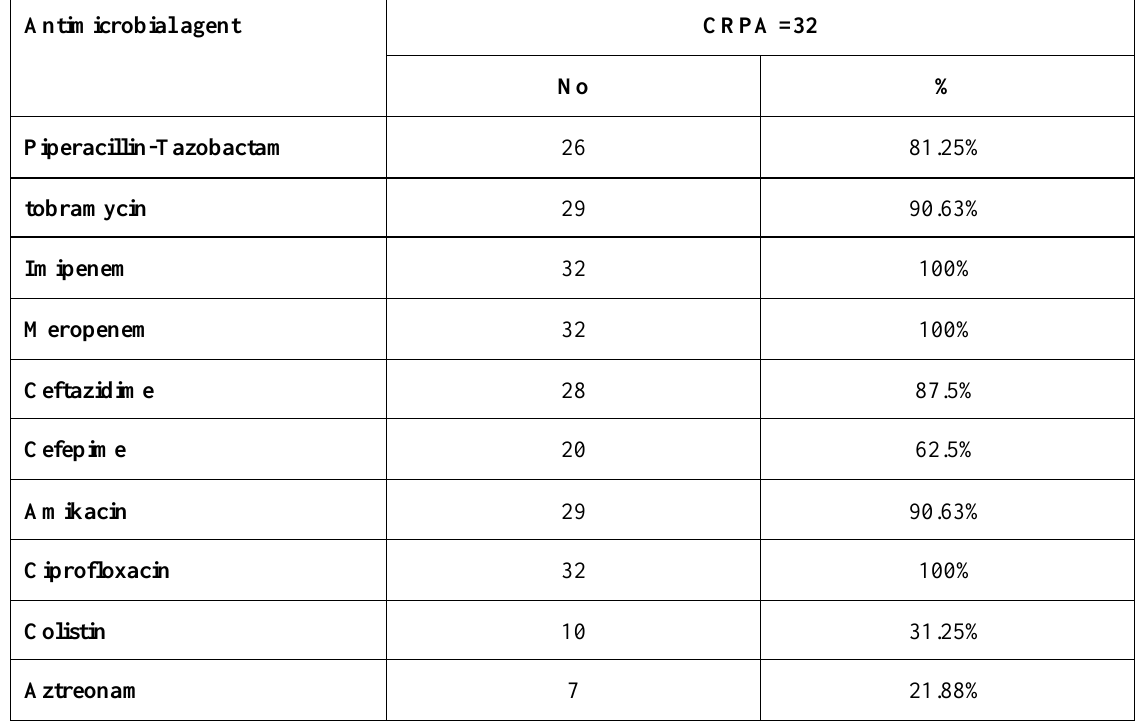
Table 2. Antimicrobial resistance rate among CRPA strains. Antimicrobial